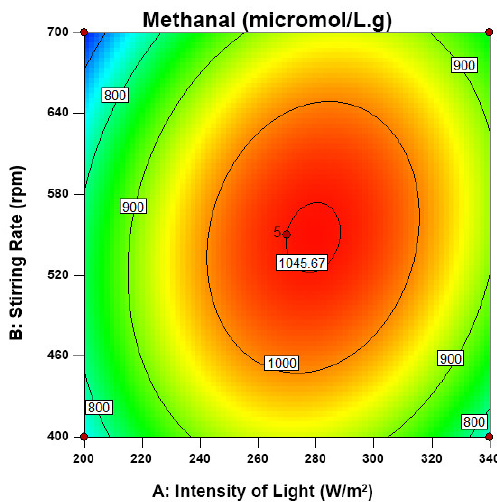
Figure 11. 2D contour diagram for representing methanol yield based on intensity of light and stirring rate.